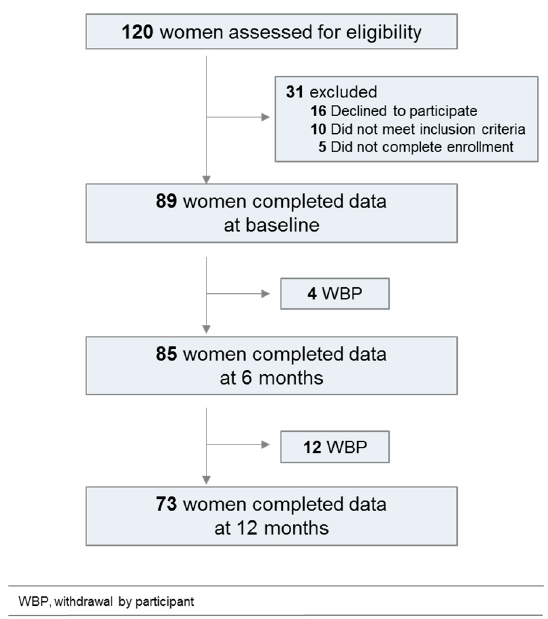
Figure 1. Flowchart of the study population.